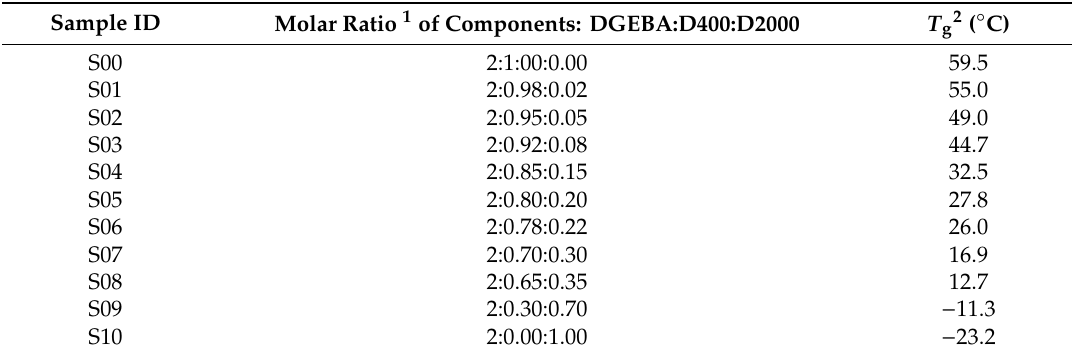
Table 1. List of prepared